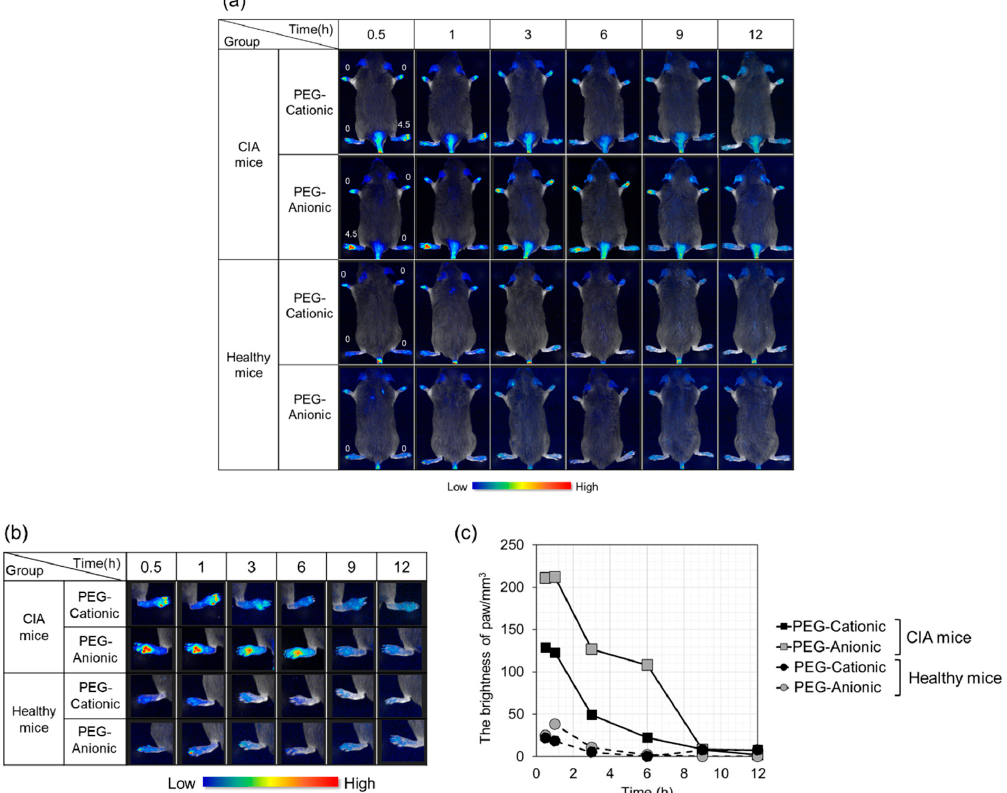
Figure 2. In vivo imaging and brightness of polyethylene glycol (PEG)-modified liposomes in CIA and healthy mice. ( a ) Liposome accumulation in the inflammatory site. Numbers indicate clinical scores. ( b ) Extended image of the paw with clinical score = 4.5. ( c ) Brightness of paws (clinical score = 4.5) determined by Maestro TM v. 2.4.